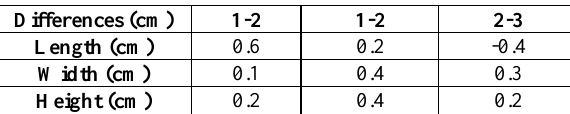
Table 2: Absolute & Relative precision between the methods